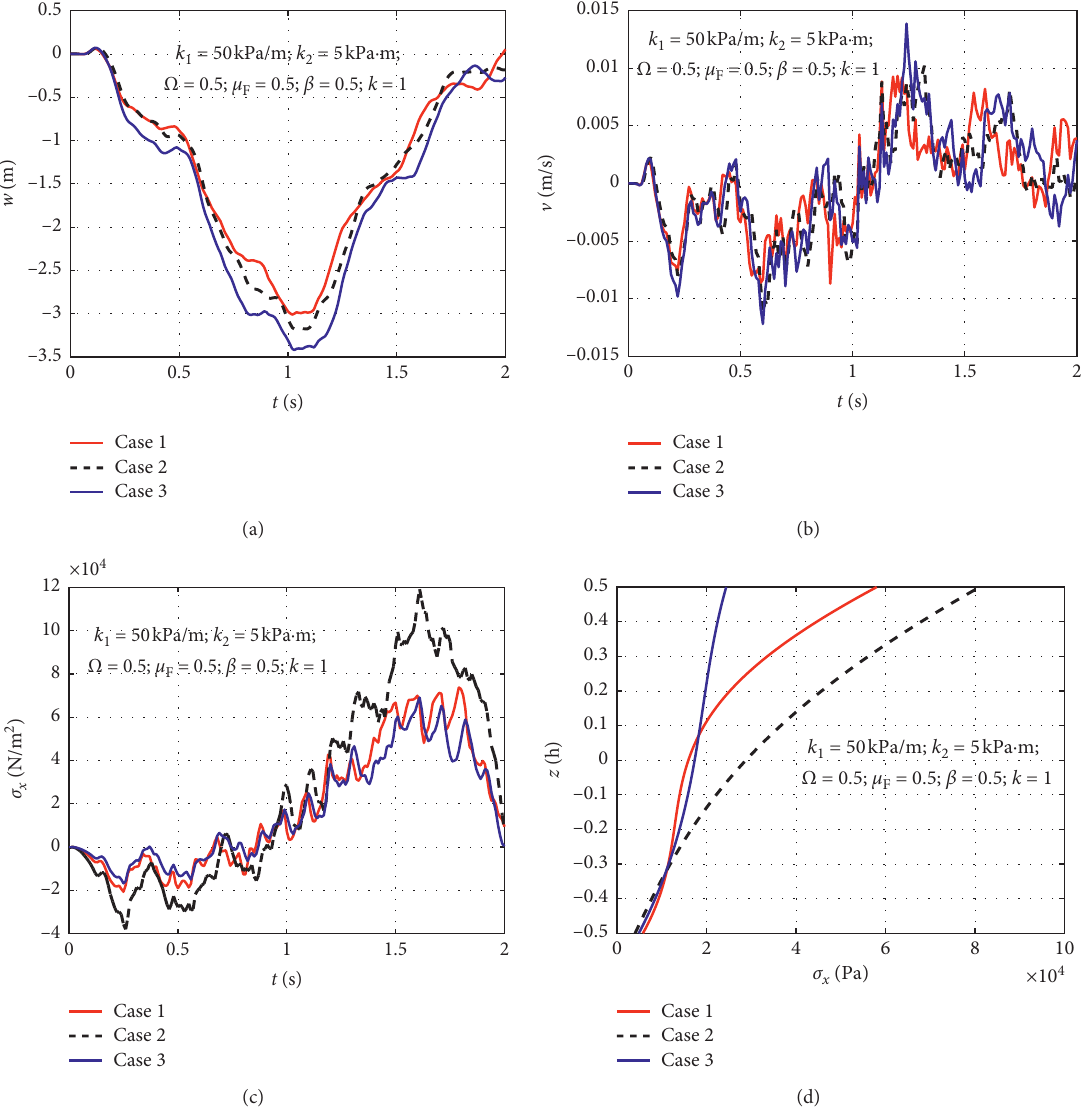
Figure 8: The responses of deflection, velocity, and stress at the central point of the plate with three different cases of the porosity distribution: (a) deflection versus time; (b) velocity versus time; (c) stress σ x versus time; (d) stress σ x through thickness.